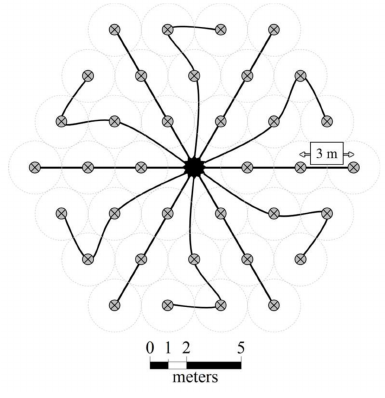
Figure 2. Schematic of the artificial source setup. Black/grey circles with crosses: orifices; black lines: polyamide